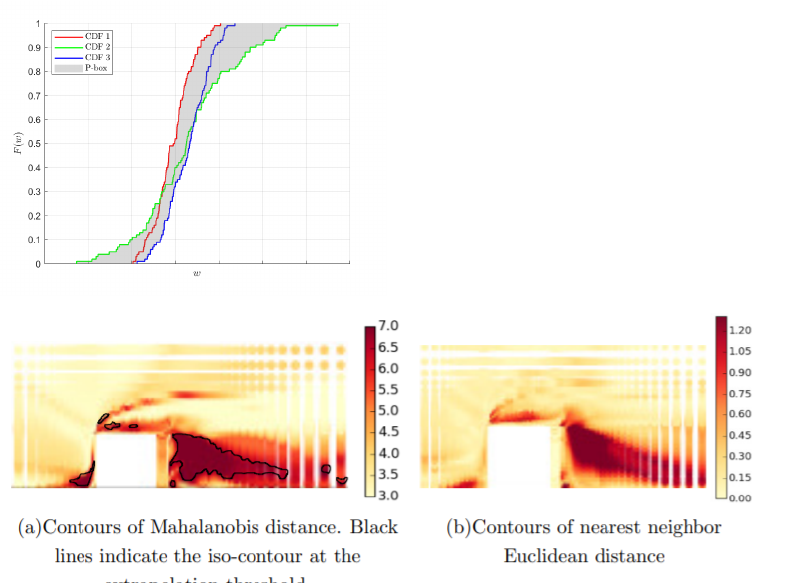
Figure 9. Perspectives for visualising the results of uncertainty analyses: illustration of a p-box ( top ) and representation of RANS uncertainty from Ling and Townsend ( bottom , adapted from [87]. Copyright 2015 AIP Publishing